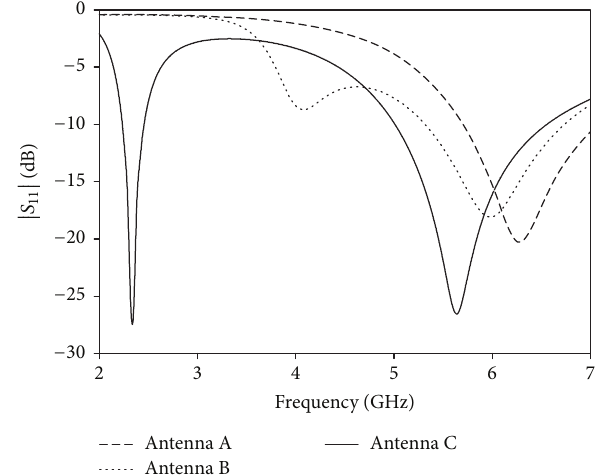
Figure 3: Reflection coefficients of antennas shown in Figure 2.